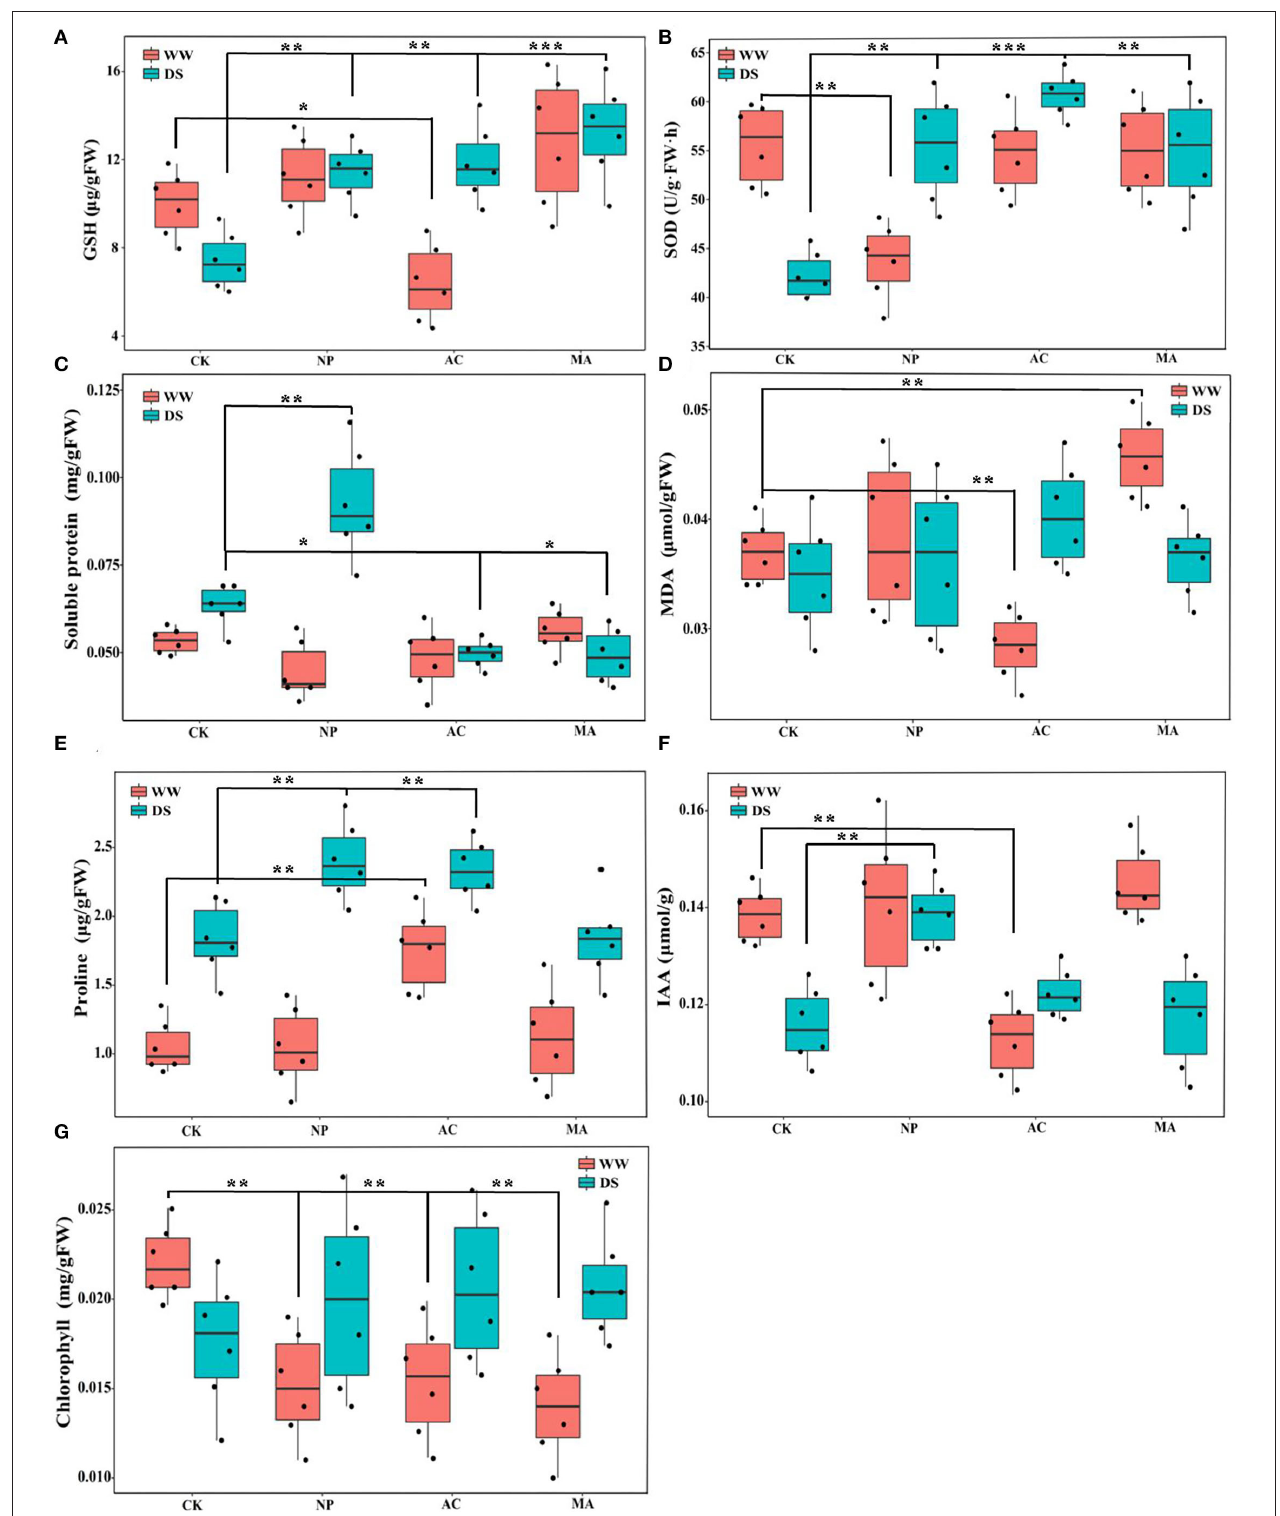
FIGURE 3 | Effect of different dark septate endophytes (DSE) on physiological active ingredient parameters in Lycium ruthenicum seedlings. CK, non-inoculated plants; NP, plants inoculated with Neocamarosporium phragmitis ; AC, plants inoculated with Alternaria chlamydospore ; MA, plants inoculated with Microascus alveolaris ; WW, well-watered; DS, drought stress, respectively. GSH content of Lycium ruthenicum seedlings (A) , SOD content of Lycium ruthenicum seedlings (B) , Soluble protein content of Lycium ruthenicum seedlings (C) , MDA content of Lycium ruthenicum seedlings (D) , Proline content of Lycium ruthenicum seedlings (E) , IAA content of Lycium ruthenicum seedlings (F) , and Chlorophyll content of Lycium ruthenicum seedlings (G) . The * symbol indicates the significant difference P < 0.05. The ** symbol indicates the significance level intervenes between P < 0.01. The *** symbol indicates difference is very significant, P < 0.001. Frontiers in Plant Science |